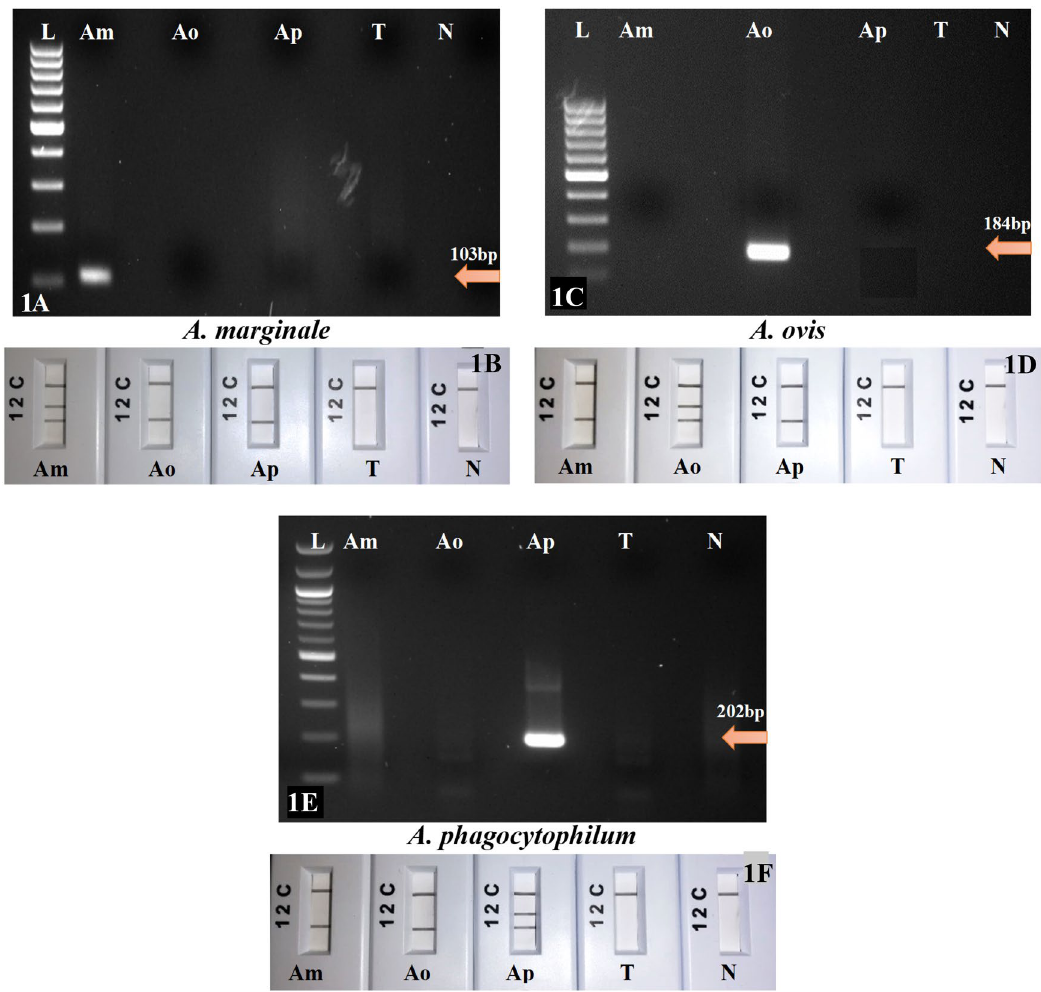
Figure 1. Specificity assay among Anaplasma species electrophoresed products obtained by RPA-basic primers in the top panel and the multiplex RPA- nfo reactions in corresponding PCRD lateral flow devices in the bottom panel. ( A ) Gel-based RPA primers. Lane L, 100 bp DNA ladder; lane Am, A. marginale; lane Ao, A. ovis; lane Ap, A. phagocytophilum; lane T, lab-reared tick DNA; lane N, non-template control (NTC, water). ( B ) Multiplex RPA- nfo primers and probes. Lane C, flow-check line; Lane 2, detects FAM/Biotin labelled amplicons ( Anaplasma species); Lane 1, detects DIG/Biotin labelled amplicons (GAPDH—internal control); Am, A. marginale; Ao, A. ovis; Ap, A. phagocytophilum; T, lab-reared tick DNA; N, non-template control